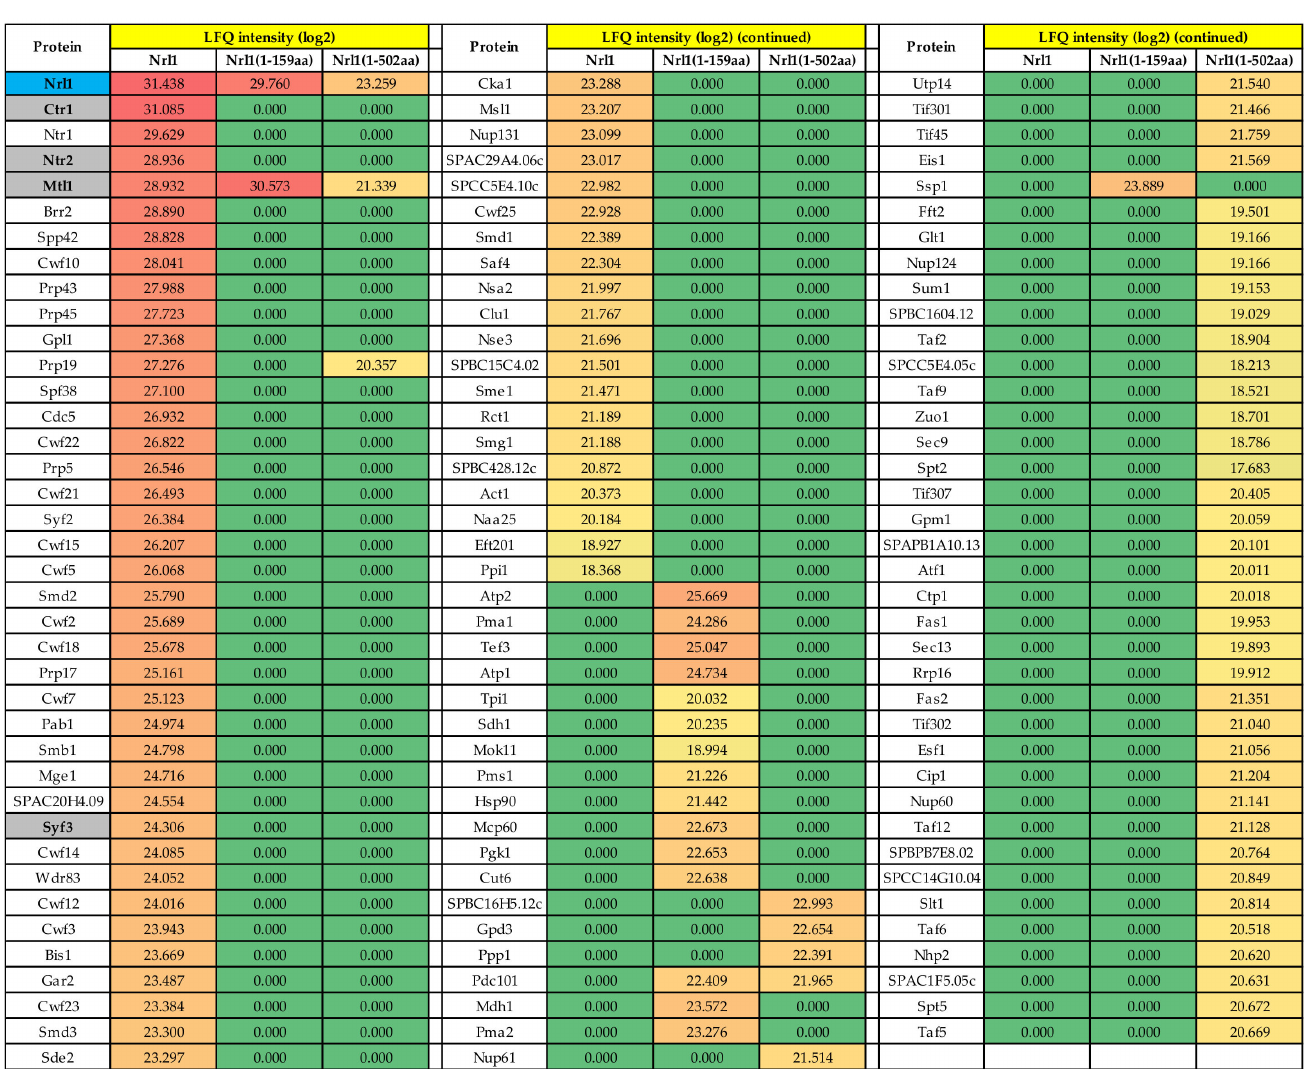
Figure 4. Proteins co-purifying with TAP-tagged Nrl1 and its truncated forms Nrl1(1–159aa) and Nrl1(1–502aa). RNA- processing factors analyzed for their interactions with Nrl1 protein using BACTH assay (see Figure 1) are highlighted in grey. Common contaminants such as ribosomal proteins and proteins identified in mock purification are excluded from this list. All identified proteins are listed in Supplementary Table